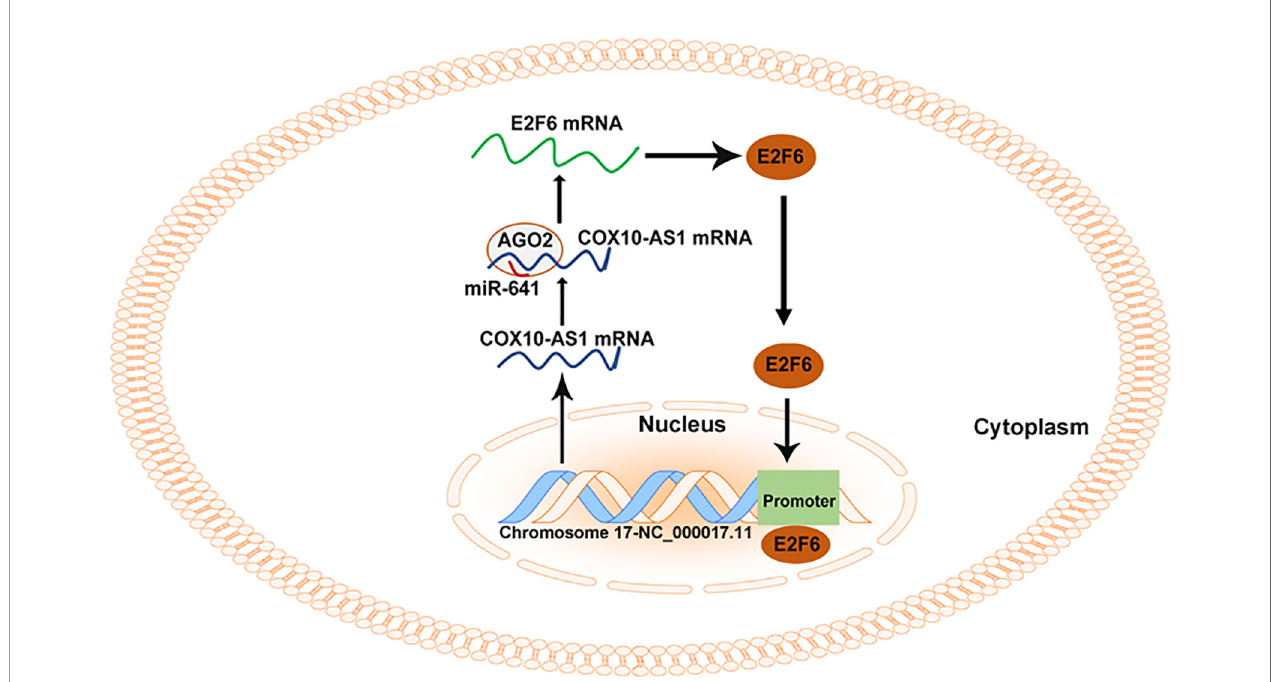
FIGURE 10 | Summary of the COX10-AS1/miR-641/E2F6 feedback loop in glioma